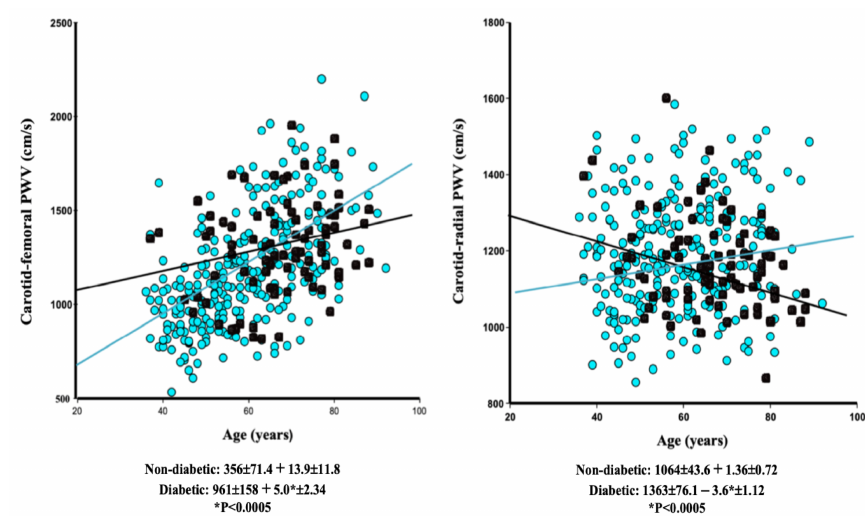
Figure 2. The age–carotid–femoral pulse wave velocity ( left ) and the age–carotid–radial pulse wave velocity ( right ) linear regression in nondiabetic (blue circles) and diabetic (black circles) end-stage renal disease patients on dialysis.